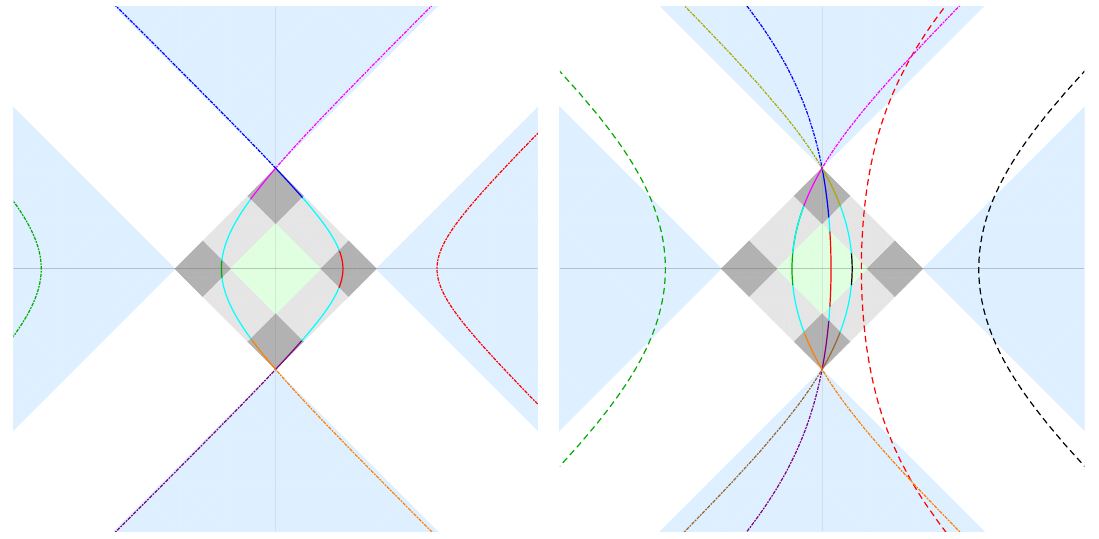
Figure 6 . Modular trajectories (solid lines) in D A passing at some x ∈ A when t = 0 and their images (dot-dashed and dashed lines) under (5.23). Left: two values of x ∈ A \ A β . Right: three values of x ∈ A β . The arcs denoted through different kind of lines but having the same colour are related through (5.23). While the dot-dashed lines span W A (light blue region, see (3.9)) as x ∈ A \ A β , the dashed lines span the entire Minkowski spacetime (the second world f M ) as x ∈ A β